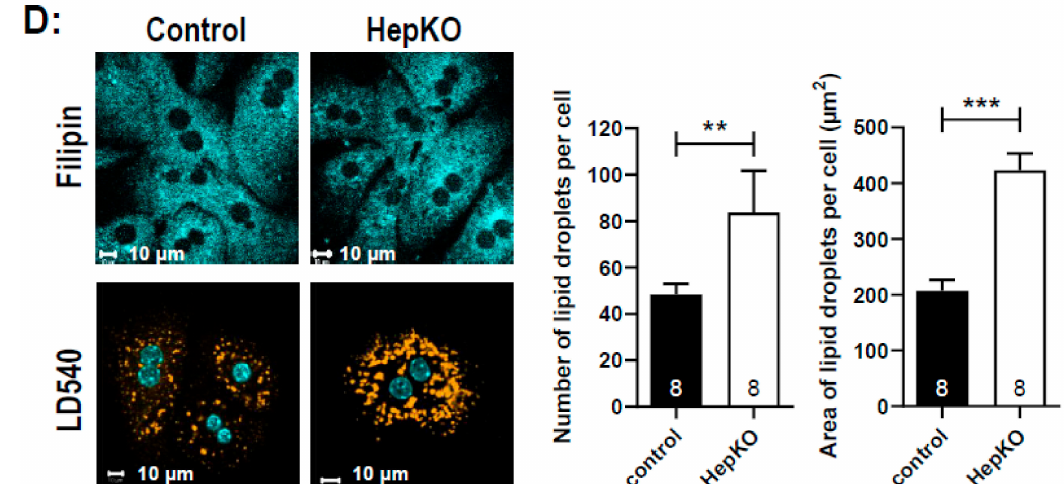
Figure 7. Characteristics of isolated hepatocytes of Sgpl1 HepKO mice. ( A – C ) Expression of mRNA and protein levels was determined by quantitative real-time PCR and Western blotting, respectively, in hepatocytes isolated from male Sgpl1 control (black bars) and Sgpl1 HepKO mice (white bars). Shown are representative blots of hepatocyte lysates of individual mice, and densitometric quantification of blots of the indicated number of mice. All values are means ± SEM. ** p < 0.05, *** p < 0.001 in nonparametric Mann-Whitney test (mRNA) or two-tailed Student’s t -test (protein). ( D ) Hepatocytes of Sgpl1 control and Sgpl1 HepKO mice were stained with filipin (cholesterol), LD540 (neutral lipids) and DAPI (DNA), as indicated. Bars, 10 µ m. Quantification of the number of lipids droplets per cell was performed with ImageJ, using images from eight mice per group as detailed in the Section